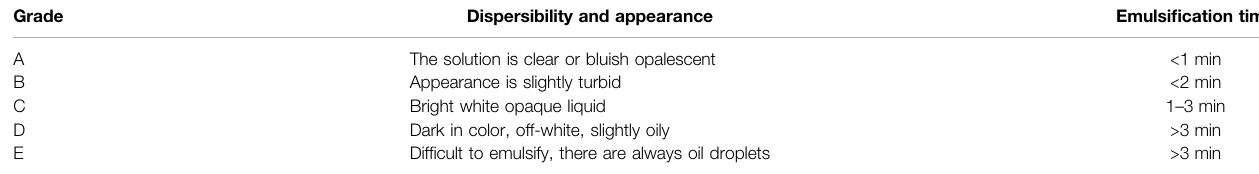
TABLE 1 | Visual test grading system used to evaluate self-emulsi fi cation performance.